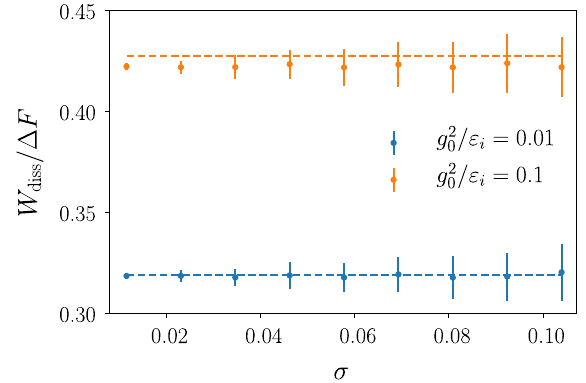
FIG. 14. Dissipated work for noisy protocols in the RL model. Each data point represents 100 realizations of a random protocol with relative error σ in the timing of each stroke (see main text for details). The points show the mean while the error bars show the variance of the dissipated work for a noisy protocol with k ¼ 2 and quadratic scaling of the switch-on and switch-off τ τ weak k 2 τ weak =k 2 . Dotted lines times: τ and τ on ¼ off ¼ iso ¼ on iso show the work done for noiseless reference protocols with 2 ε 1 . 1 , g 2 τ weak k ¼ 1 . Parameters are ε , βε ¼ 0 . 15 , 0 f ¼ i i ¼ on ; off g 2 0 τ weak ¼ 1 . 5 , and Λ = ε i ¼ 100 iso